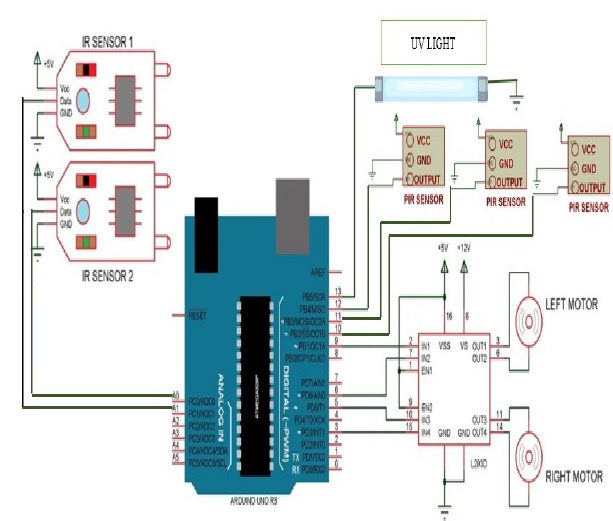
Figure 6 . Circuit